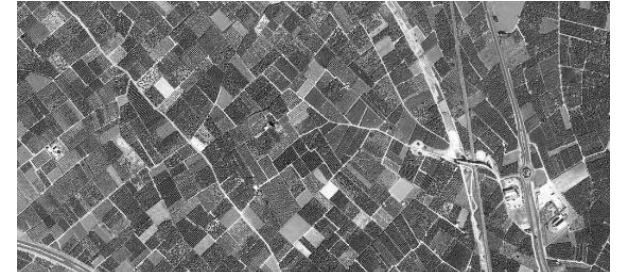
Figure 15. Guadassuar.Valencia.Spain before 2007 crisis.